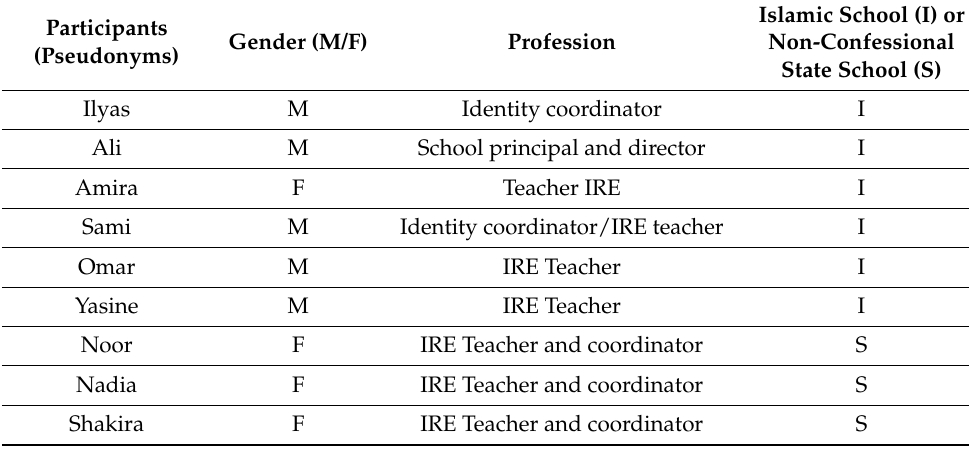
Table 1. Characteristics of participants focus group 1 (N = 9).